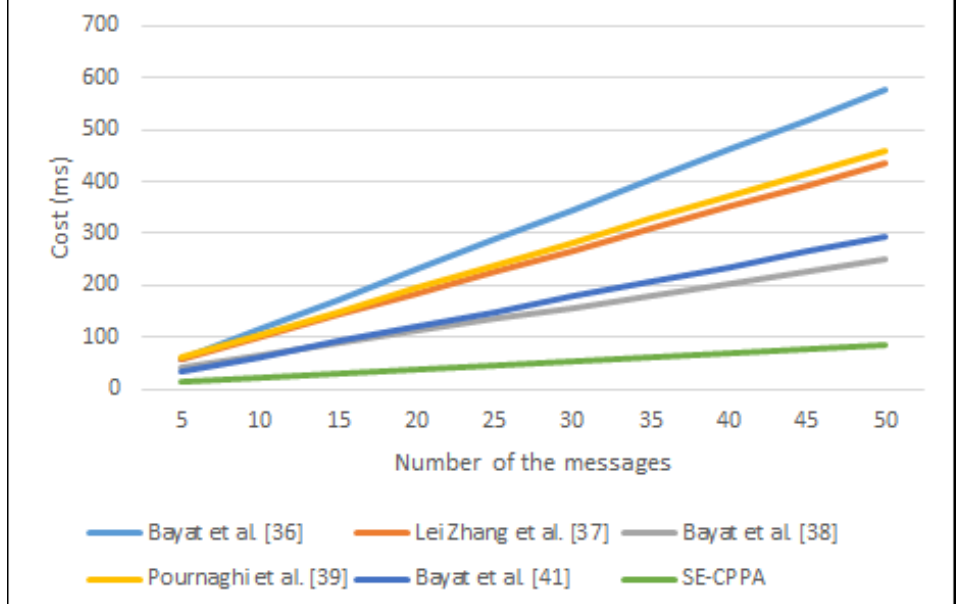
Figure 7. The comparison of batch-signature verification process.